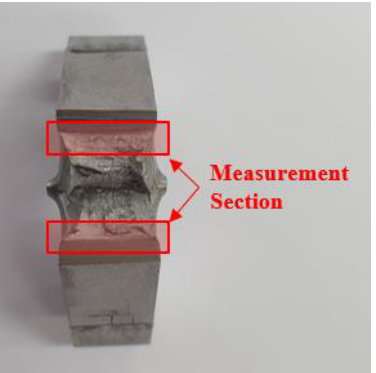
Figure 5. Typical fracture surface according to ductility and brittleness. ( a ) Ductile fracture; ( b ) brittle fracture.